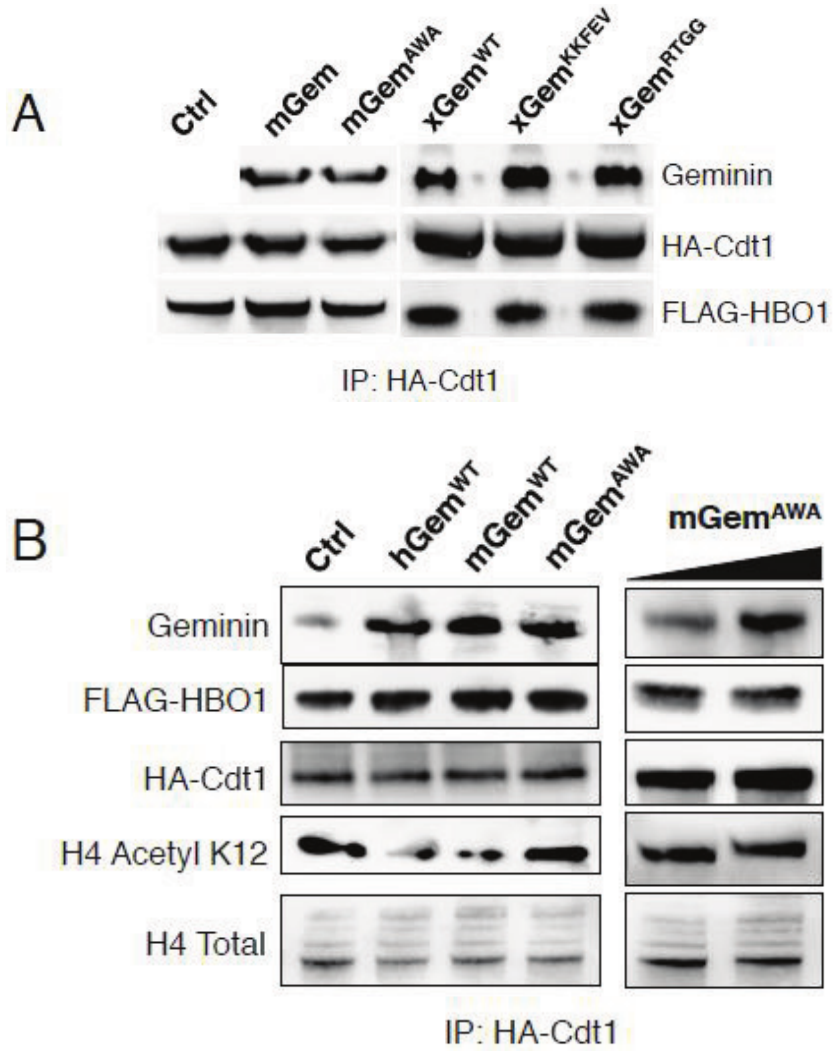
Figure 5. Geminin AWA does not inhibit HBO1 acetyltransferase activity. ( A ) Geminin AWA forms a ternary complex with Cdt1 and HBO1. HA-Cdt1:FLAG-HBO1 complex was precipitated from HeLa cells expressing both proteins using anti-HA antibody. The precipitate was incubated with recombinant Geminin, and after extensive washing the amount of Geminin incorporated into the complex was determined by immunoblotting. ( B ) Geminin AWA does not inhibit HBO1. HA-Cdt1:FLAG-HBO1 complex was purified using anti-HA antibody as in part (A), eluted with HA peptide, then incubated with acetyl coenzyme A, histone H4 peptide, and different recombinant Geminin proteins. The amount of acetylated histone H4 peptide was determined by